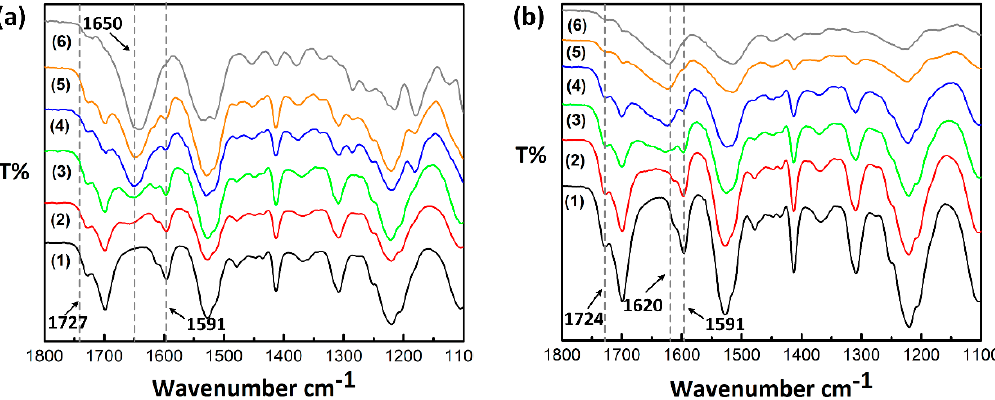
Figure 4. Fourier Transform Infrared (FT-IR) spectra: ( a ) before spinning (film); and ( b ) after spinning (fibres) ((1) PU 100%; (2) PU/RSF 90/10; (3) PU/RSF 75/25; (4) PU/RSF 50/50; (5) PU/RSF 25/75; and (6) PU/RSF 10/90).